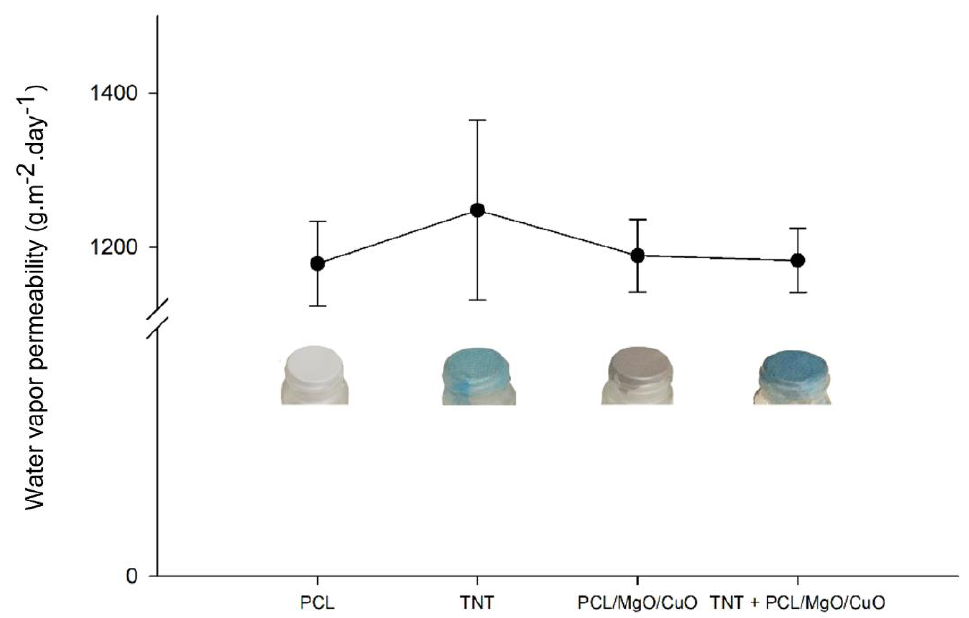
Figure 5. Water vapor permeability test for PCl electrospun meshes, commercial TNT, PCL electro- spun meshes dopped with CuO/MgO NPs, and TNT attached to PCL/MgO/CuO electrospun mesh. No statistical significance was observed between samples ( p > 0.05 ( n = 5)).